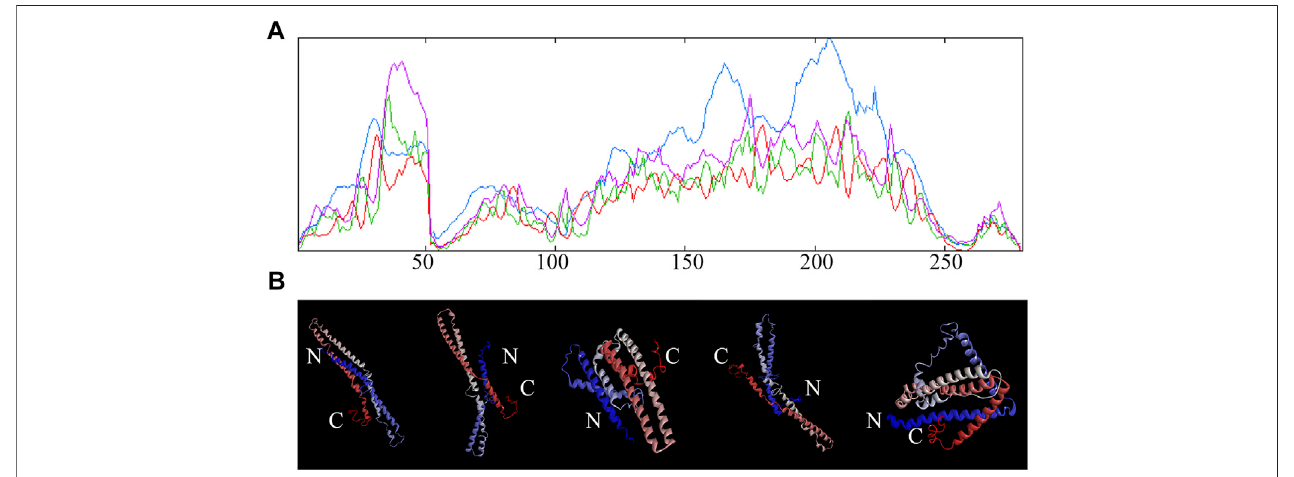
FIGURE 7 | Secondary and tertiary structure of potato StTGA39 protein. (A) Secondary structure of StTGA39 was predicted by SOPMA in potato. Blue lines represent alpha-helix, purple lines represent random coil, red lines represent extended strand, and green lines represent β -turn. (B) Three-dimensional structure of StTGA39 was built with the I-TASSER web server.